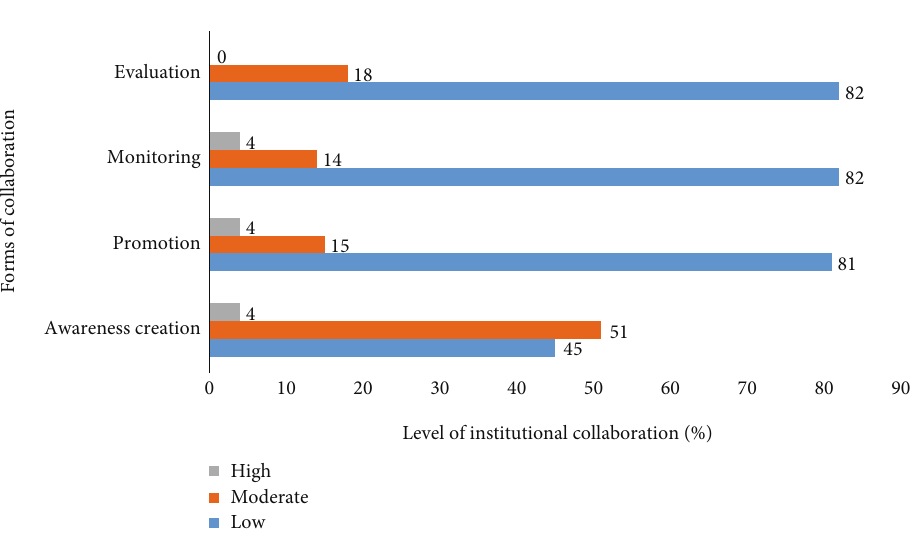
Figure 1: Institutional involvement in biogas promotion.